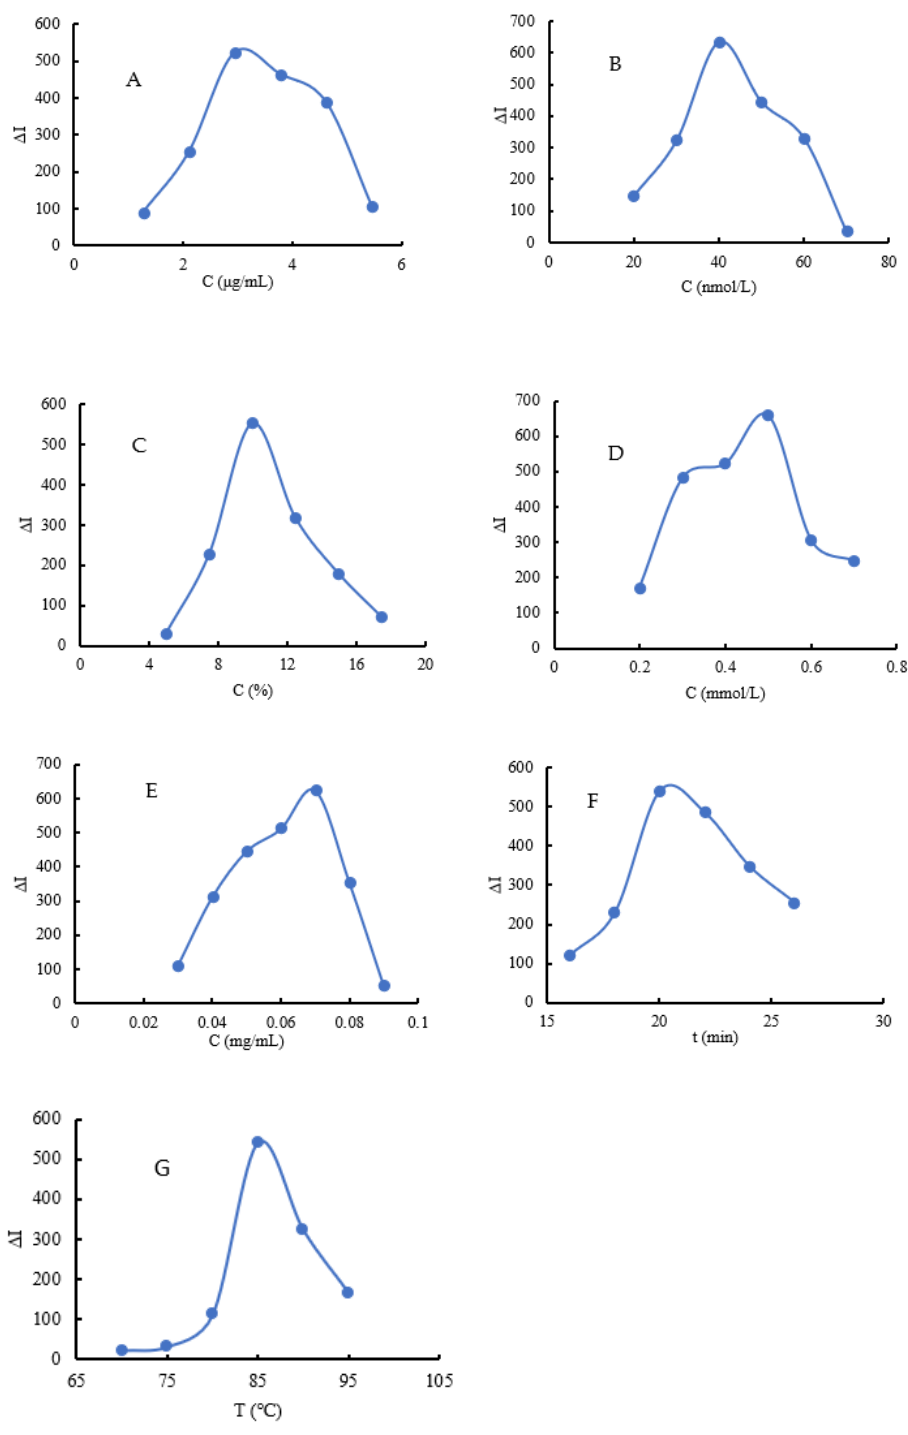
Figure 6. Optimization of analytical conditions. ( A ): the concentration of CD N ; ( B ): the concentration of Apt As ; ( C ): the percentage of Et; ( D ): the concentration of HCI; ( E ): the concentration of HAuCl 4 ; ( F ): the reaction time; and ( G ): the reaction